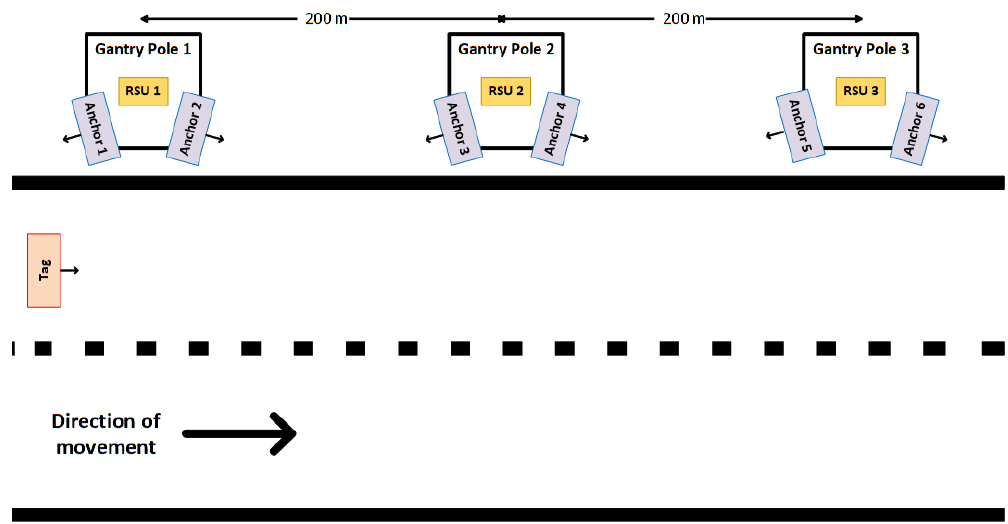
Figure 9. Representation of the testing scenario.